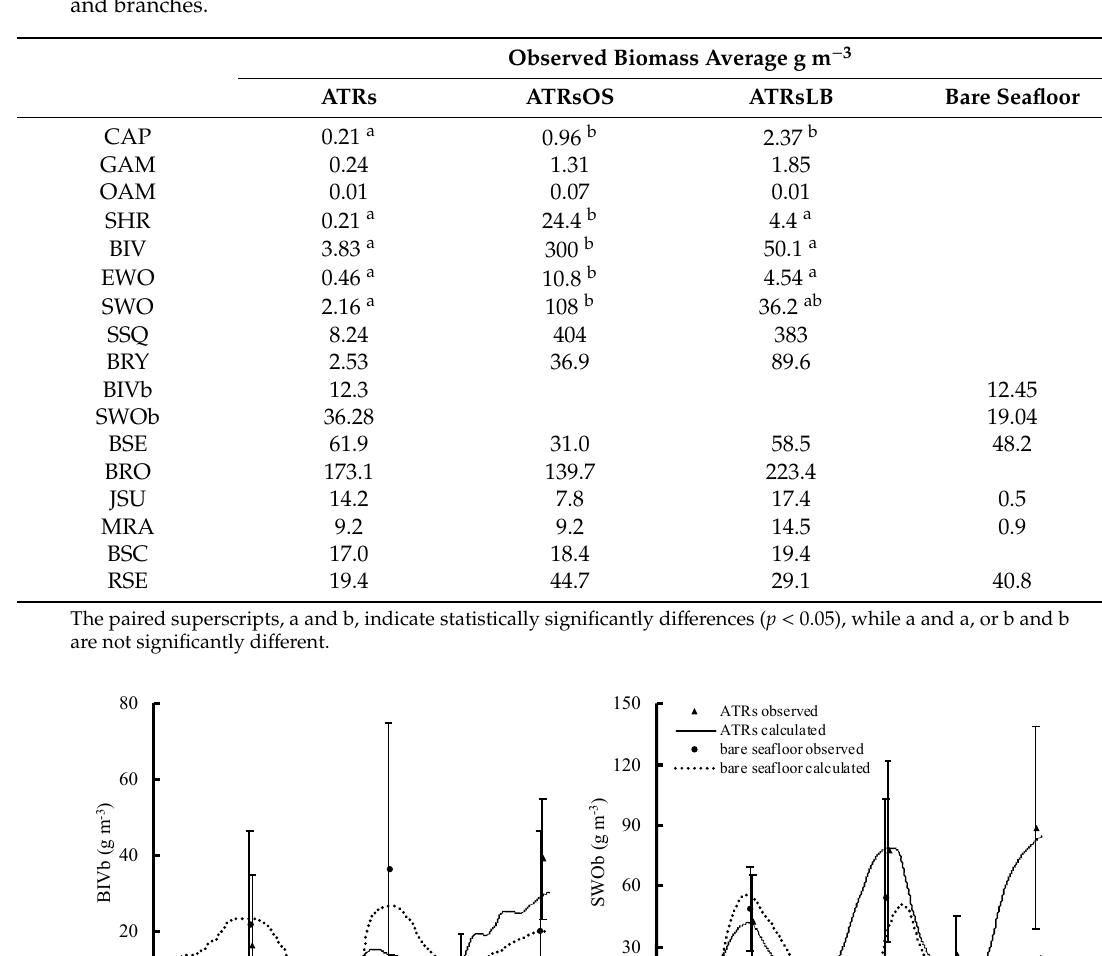
Table 4. The average observed biomass of prey and fish in artificial timber reefs (ATRs) and bare seafloor. One-way ANOVA was applied to check if there were statistical di ff erences between the groups. ATRsOS: artificial timber reefs with oyster shells, ATRsLB: artificial timber reefs with leaves and branches.